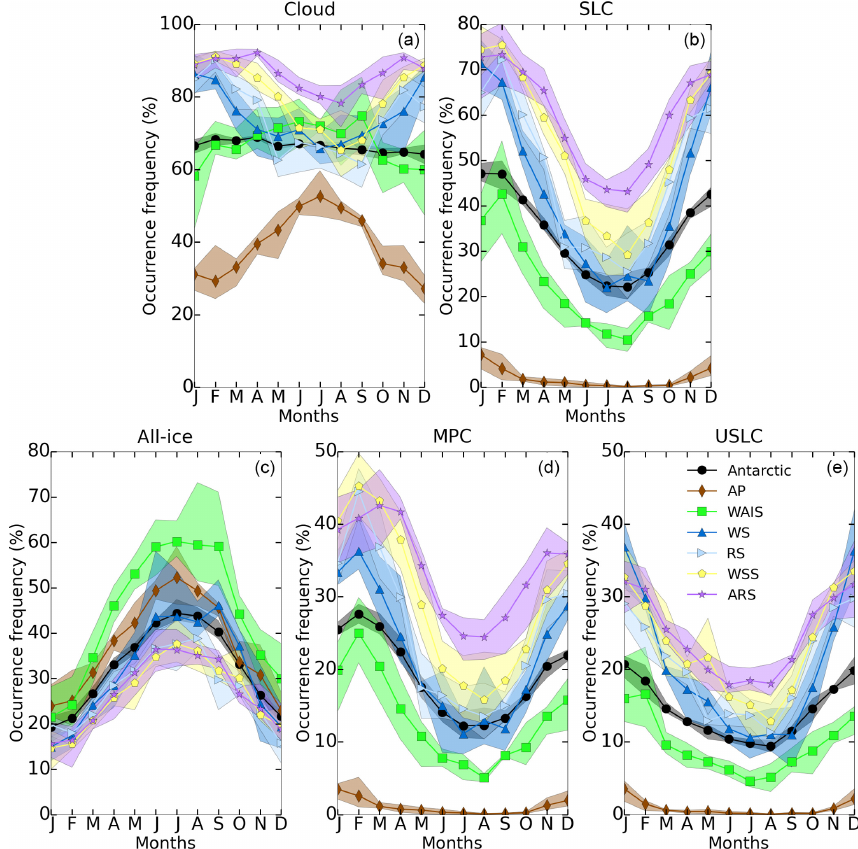
Figure 9. Four-year (2007–2010) average monthly time series of the total cloud fraction (a) , SLC fraction (b) , all-ice fraction (c) , MPC fraction (d) , and USLC fraction (e) . See Sect. 3.2 for the definition of the cloud categories. The different colours correspond to the different investigated regions (see map in Fig. 4c): WSS (in the Weddell Sea sector), ARS (for the Amundsen–Ross sector), WS (in the Weddell Sea), RS (in the Ross Sea), the WAIS (on the West Antarctic Ice Sheet) and AP (Antarctic Plateau). The shaded areas indicate the amplitude between the monthly minimum and maximum encountered over the years from 2007 to